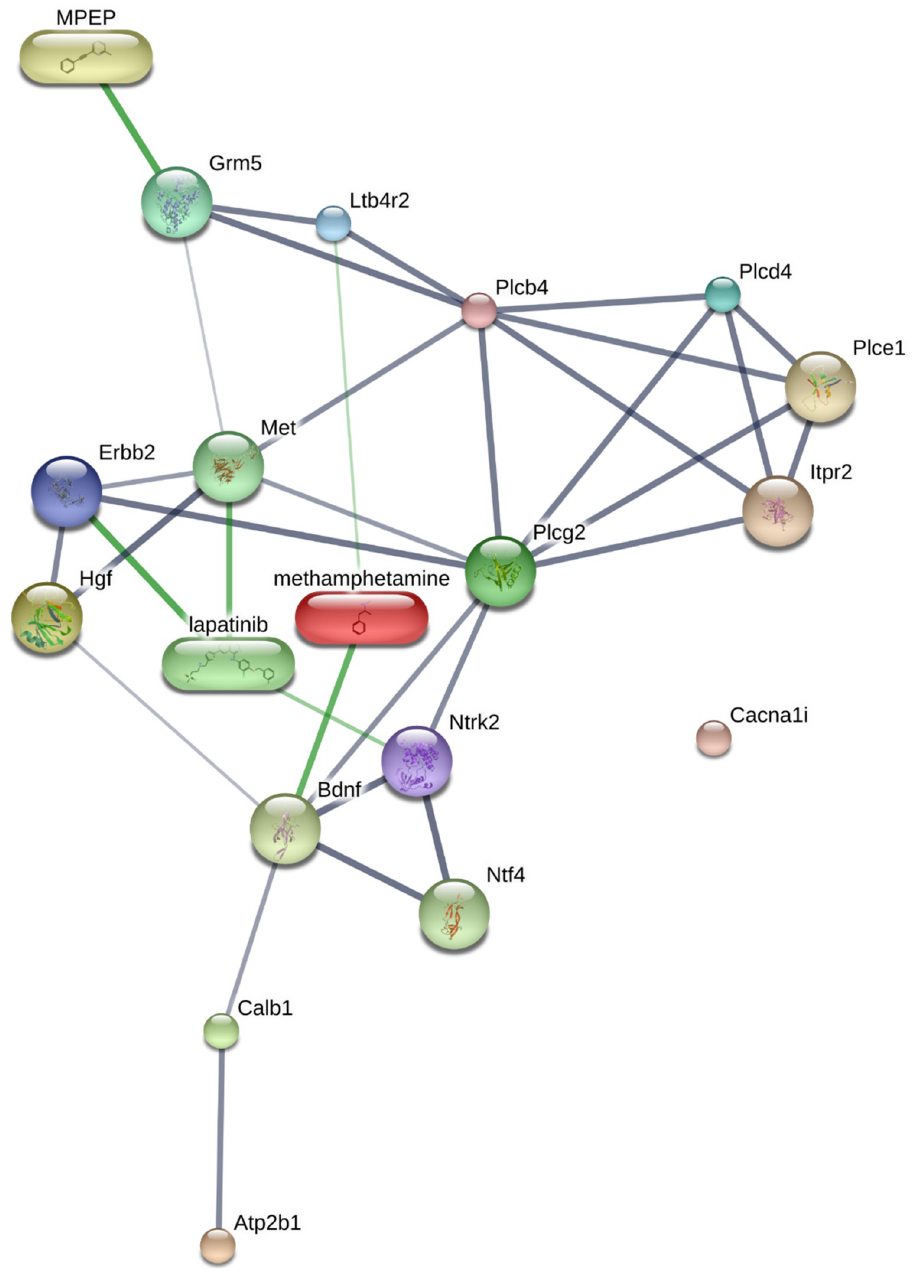
Fig 2. Predicted interactions between METH and differentially expressed proteins of the calcium signalling pathway in rat testis.